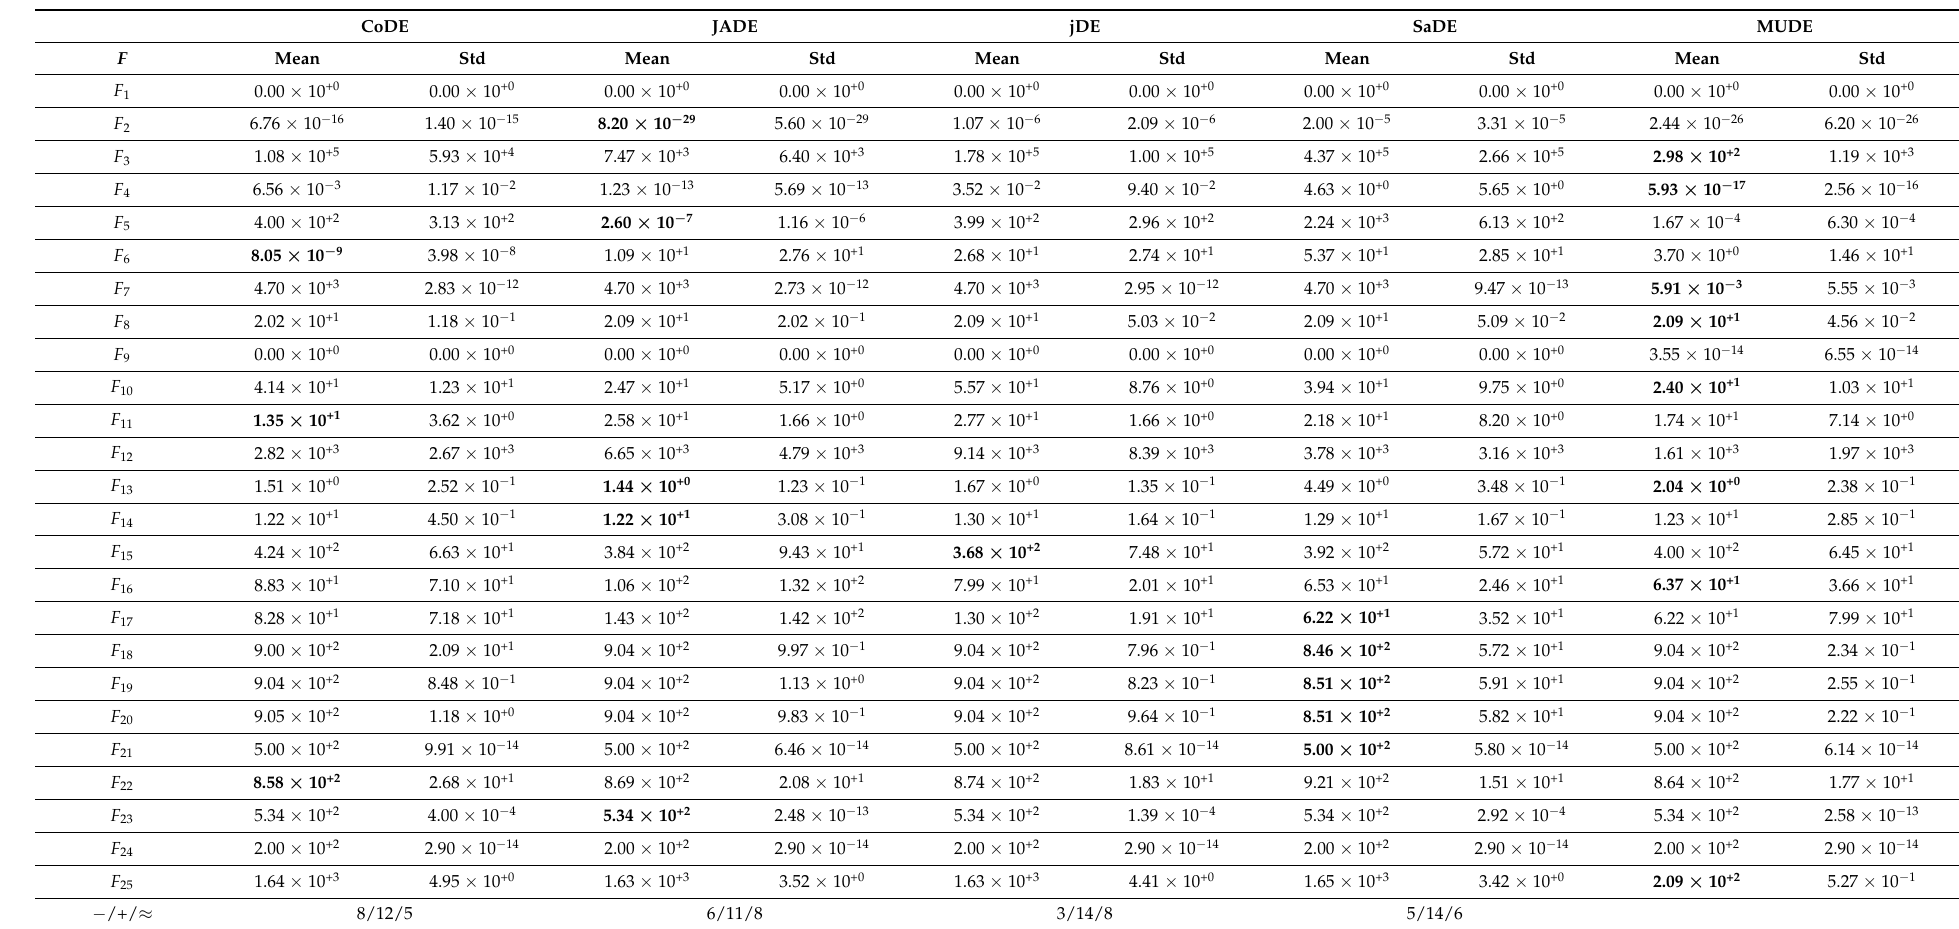
Table 2. Comparison with other DE algorithms for dimension =